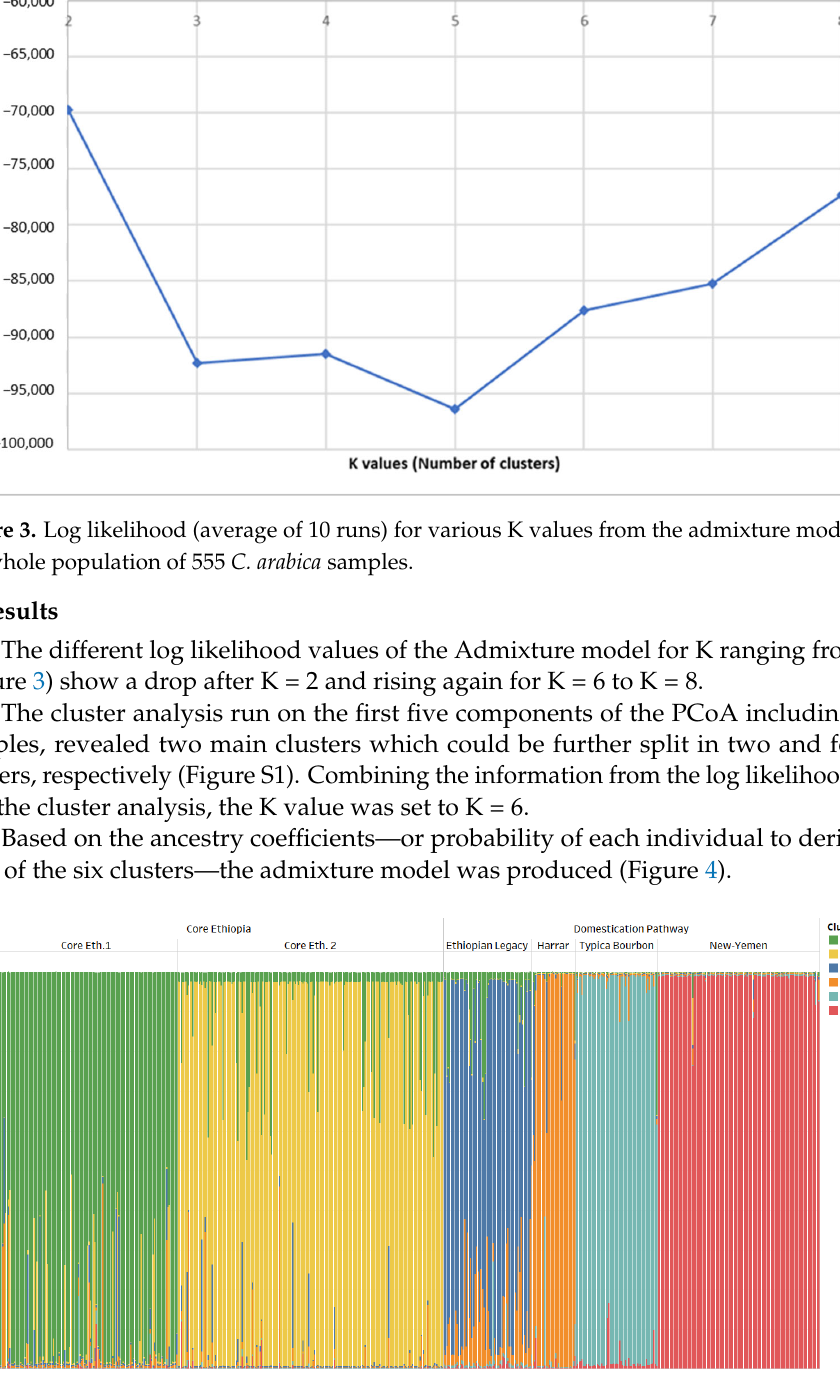
Figure 4. Ancestry coefficient for each individual obtained from the admixture model for the population of 555 C. arabica samples with K = 6. A total of two clusters included only samples from Ethiopia, the vast majority of which (99%) were from the southwest and south of Ethiopia—corresponding to the native habitat of C. arabica —while the remaining 1% were from the Hararghe region (Table 3). As expected, the four samples corresponding to Ethiopian landraces cultivated out of